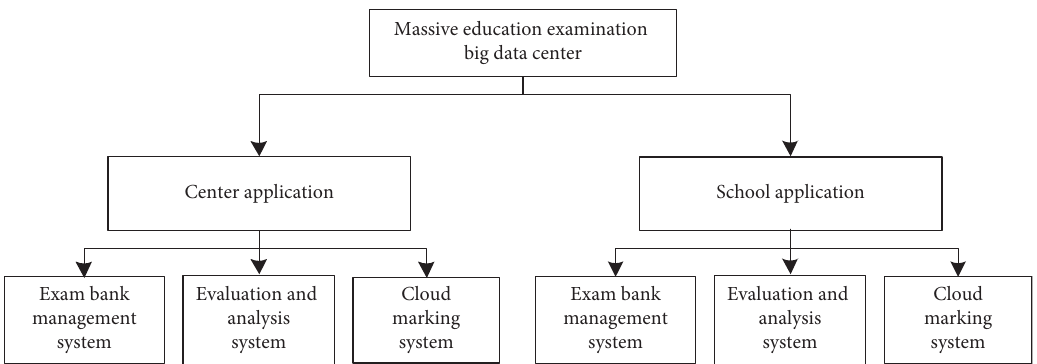
Figure 4: The overall architecture of the education examination analysis and evaluation cloud service